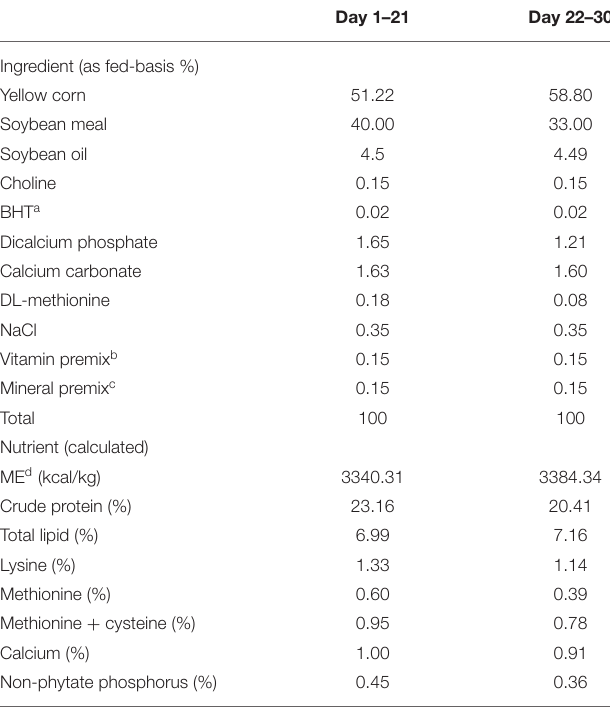
TABLE 1 | Basal diet composition and nutrient